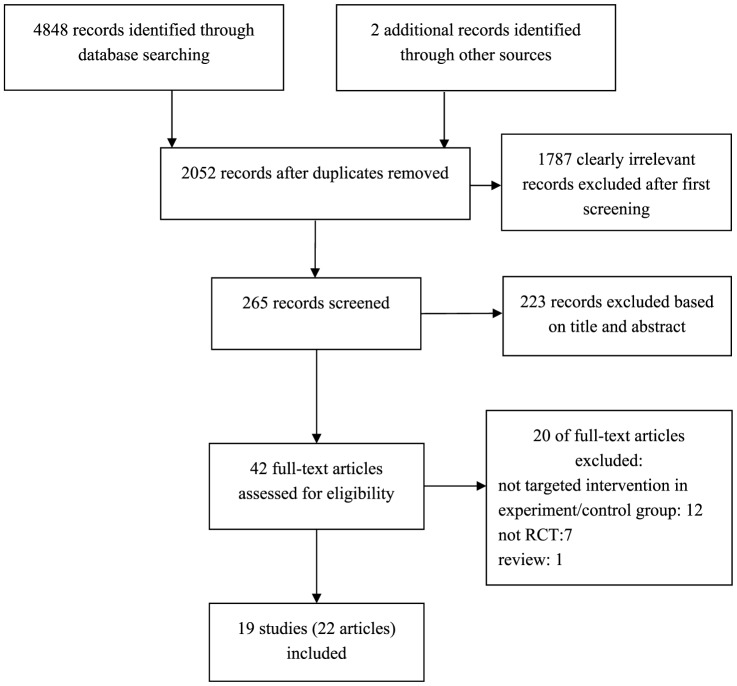
Flow diagram of article selection for inclusion.